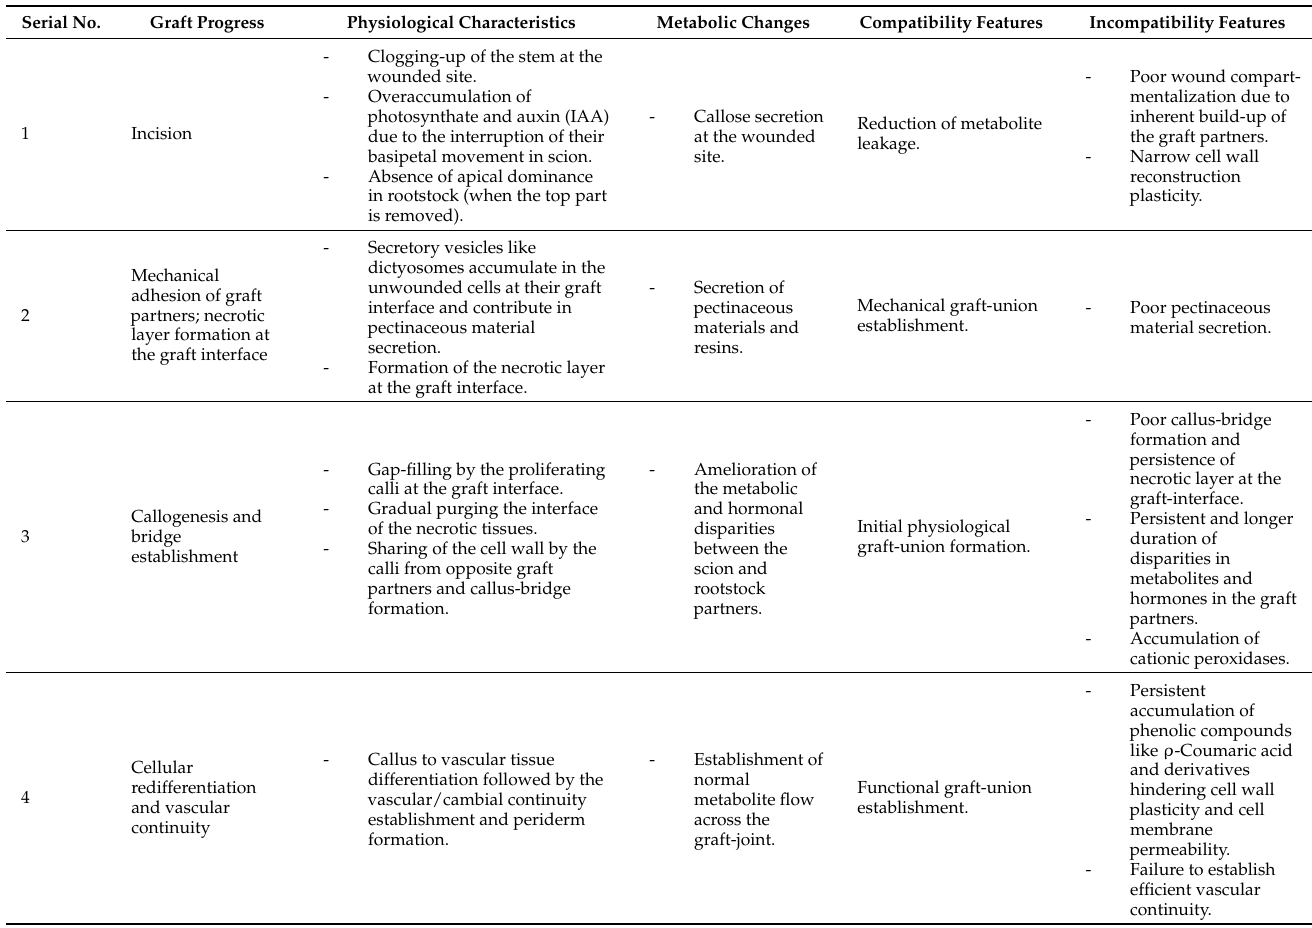
Table 1. Compatibility and incompatibility responses with graft-establishment